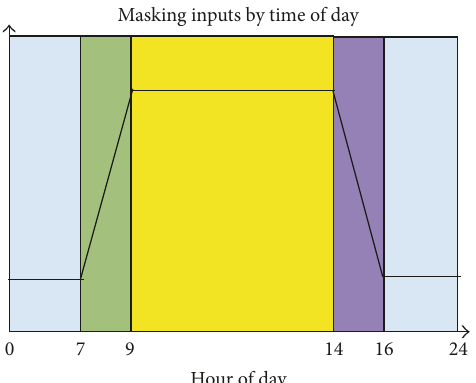
Figure 5: The four time frames of the day, selected by analysis of the cumulative error reviewed by hour. Hour 0 is midnight; hour 12 is noon.